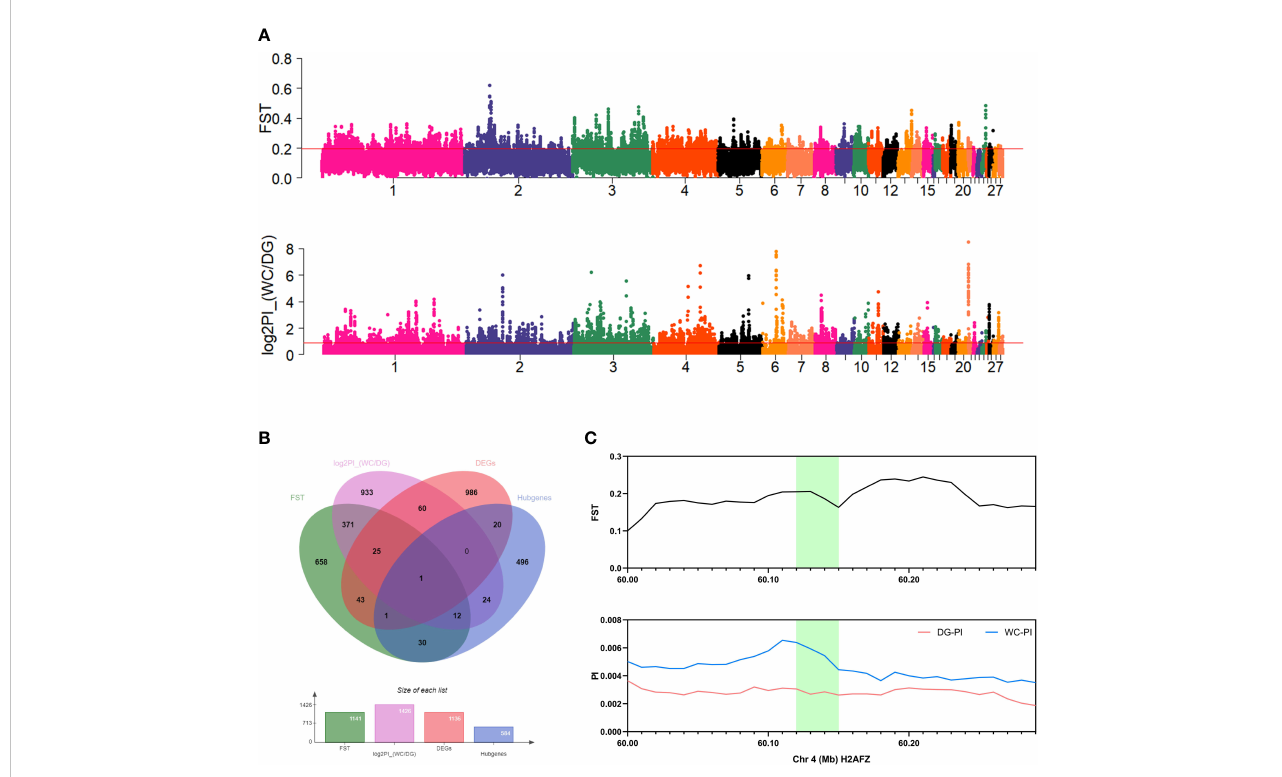
FIGURE 8 Population genomic analysis and gene colocalization. (A) Manhattan plots of FST and log 2 PI_(WC/DG) of 40 kb windows. Red lines indicate the top 5% threshold. (B) Venn diagram for the colocalization of FST, log 2 PI_(WC/DG), DEGs and hub genes. (C) FST value and PI value of colocalized genes in Dagu chickens and Wenchang chickens. Green fi llers are the H2AFZ gene located in the two regions.